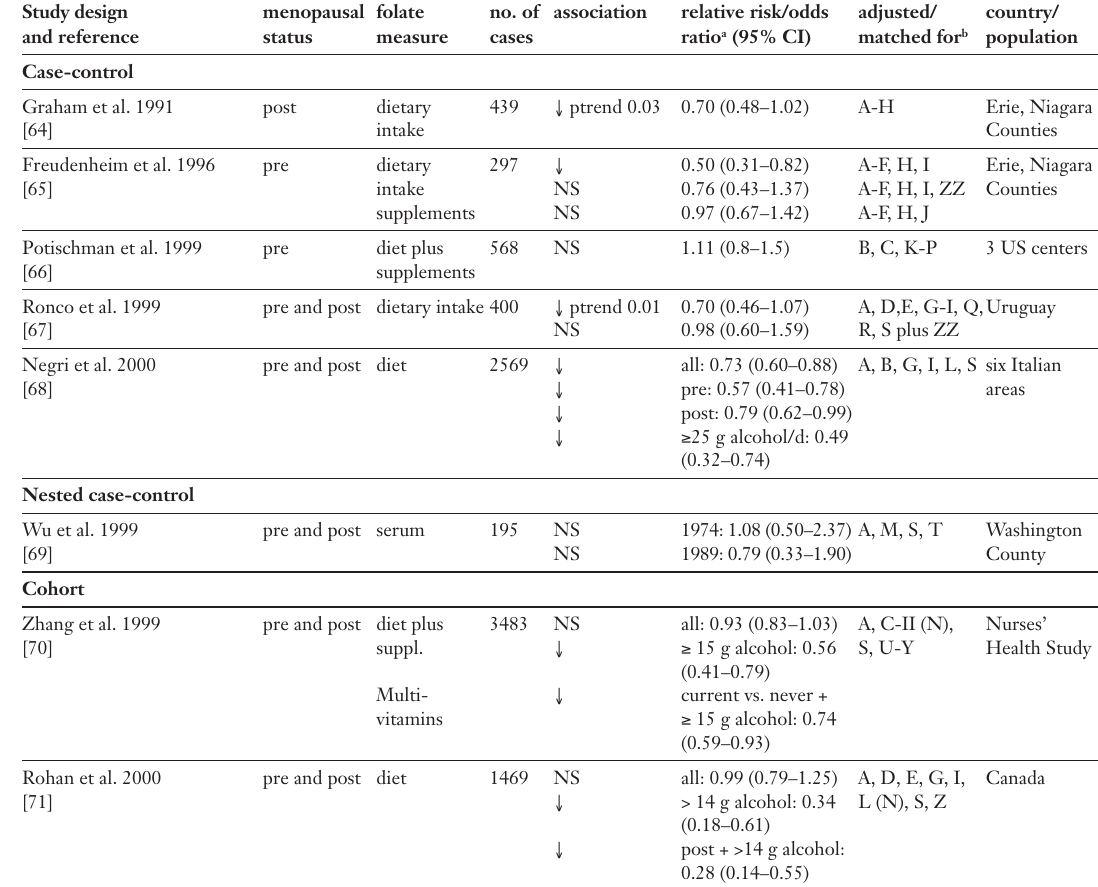
Folate and risk of breast